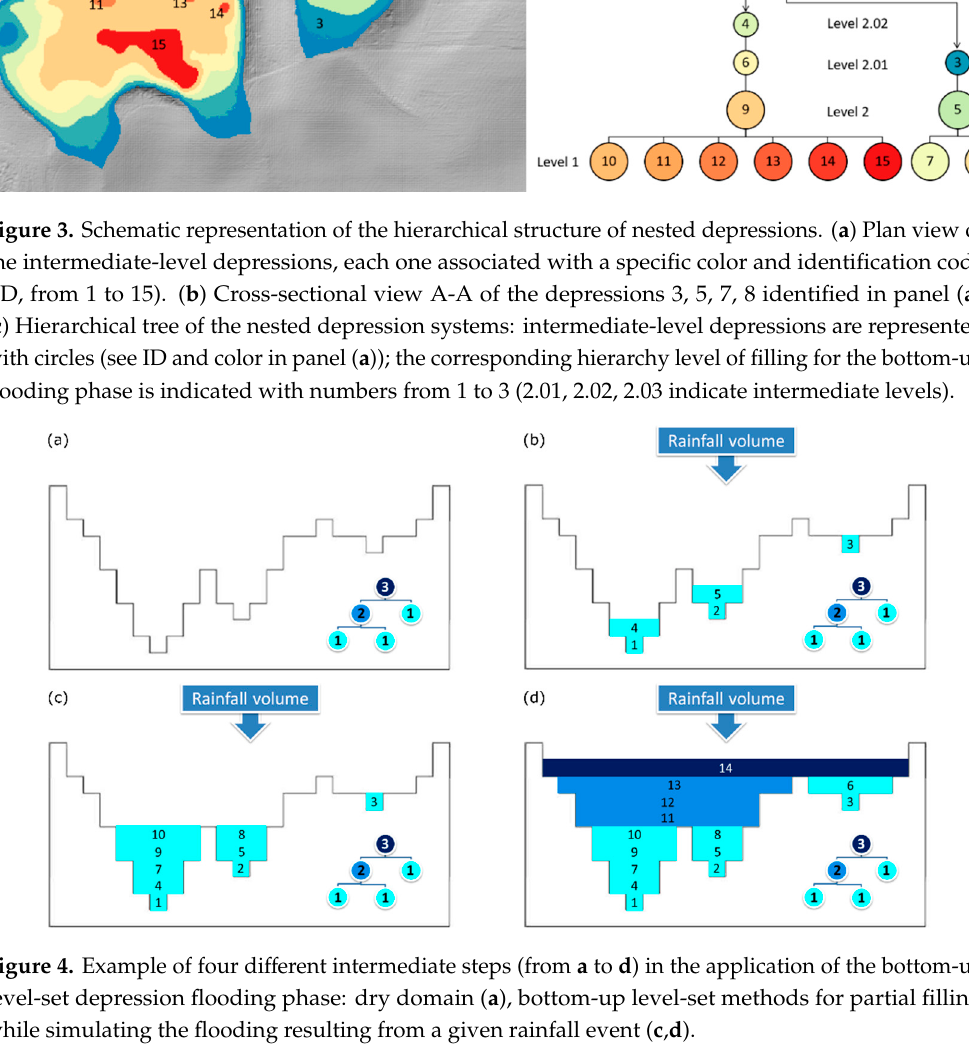
(ID, from 1 to 15). ( b ) Cross-sectional view A-A of the depressions 3, 5, 7, 8 identified in panel (a). ( c ) Hierarchical tree of the nested depression systems: intermediate-level depressions are represented with circles (see ID and color in panel (a)); the corresponding hierarchy level of filling for the bottom- up flooding phase is indicated with numbers from 1 to 3 (2.01, 2.02, 2.03 indicate intermediate levels).